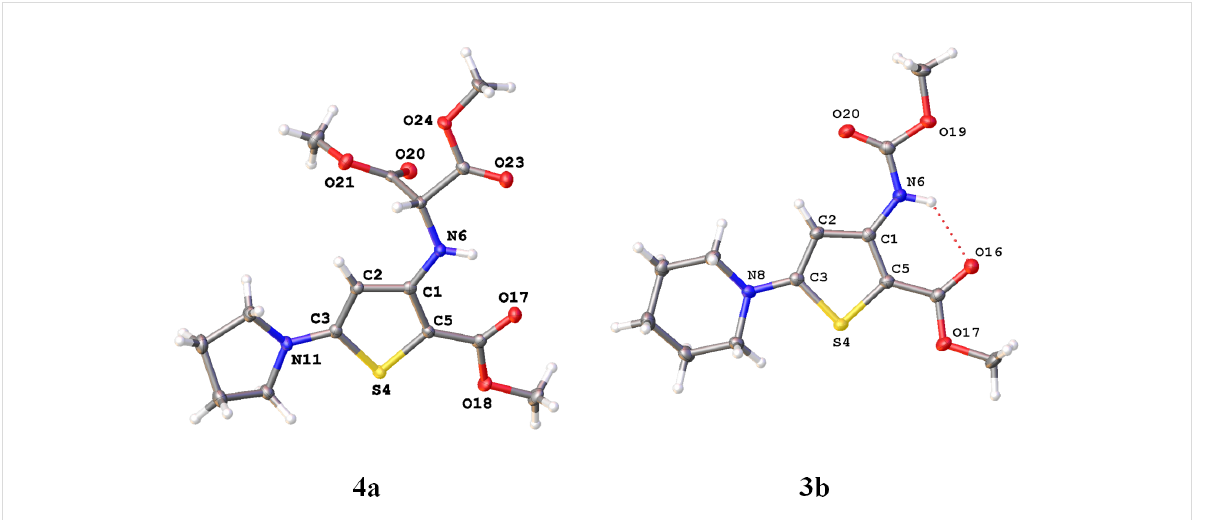
Figure 2: The structures of compounds 4a and 3b according to the data of X-ray analysis (Olex2 plot with 50% prohability level of ellipsoids).